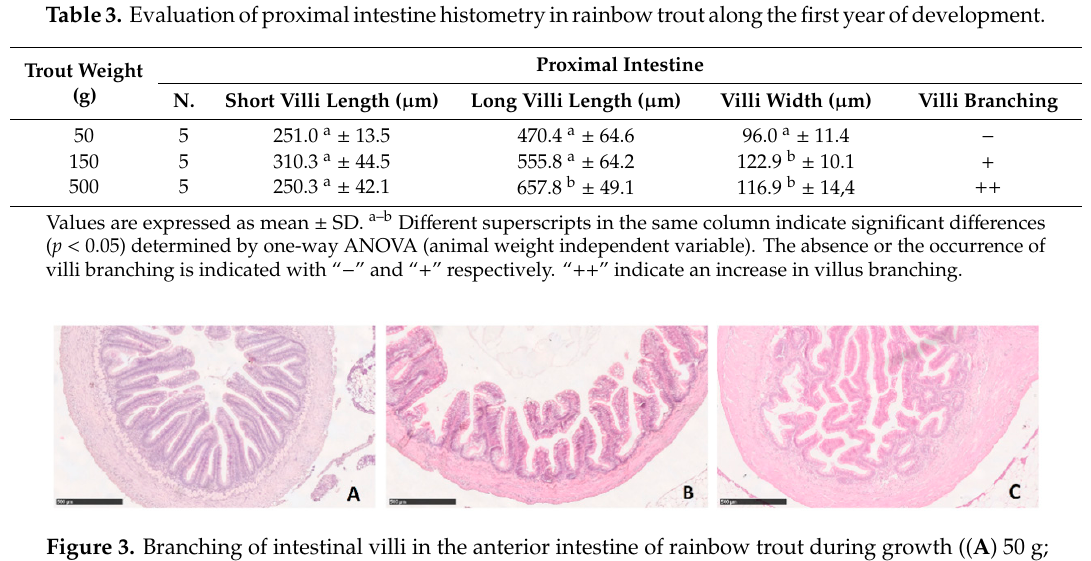
Figure 3. Branching of intestinal villi in the anterior intestine of rainbow trout during growth (( A ) 50 g; ( B ) 150 g; ( C ) 500 g). Table 4. Evaluation of distal intestine histometry in rainbow trout along the first year of development. Distal